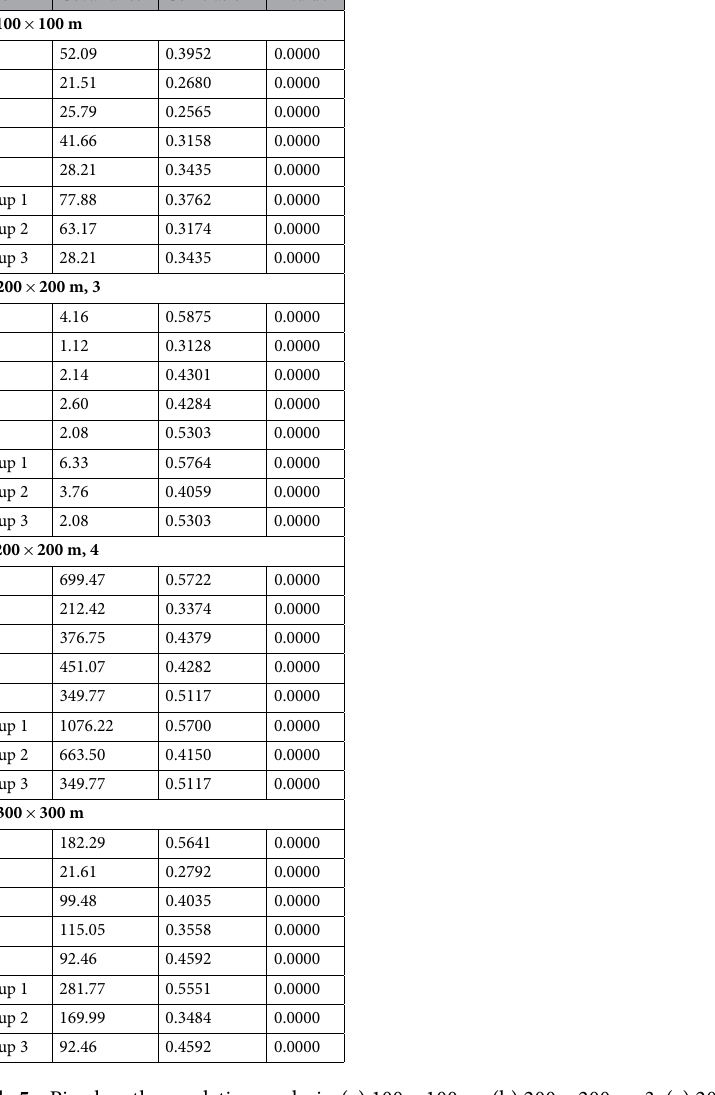
Table 5. Pipe length correlation analysis: (a) 100 × 100 m, (b) 200 × 200 m, 3, (c) 200 × 200 m, 4, (d) 300